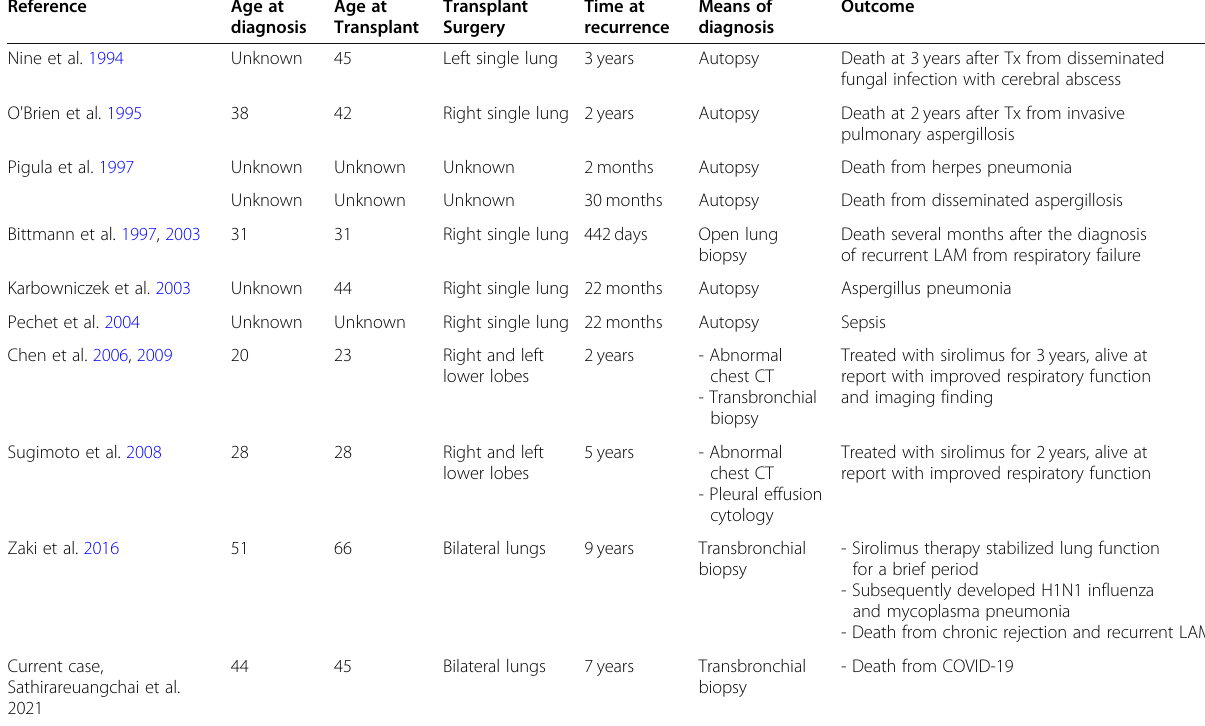
Table 1 Previously reported cases of recurrent lymphangioleiomyomatosis (LAM) in the lung allograft